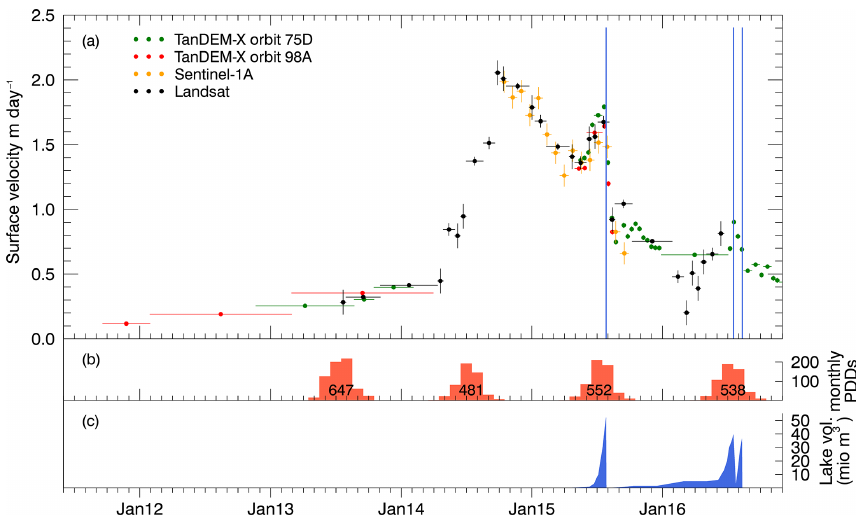
Figure 13. (a) Evolution of surface velocity at the middle of the glacier tongue (4km from the terminus, Fig. 3) from the end of 2011 until mid-2016, with horizontal bars representing the period over which velocity was calculated and vertical bars showing the velocity uncertainty. The blue vertical lines indicate GLOF events. (b) Monthly PDDs indicated by the bars, and yearly PDDs indicated by the numbers. (c) Temporal change in lake volume as calculated from lake extent on satellite